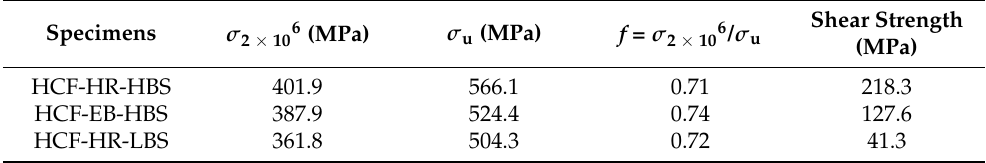
Figure 10. Comparison of the fatigue S-N curves between polished specimens and corresponding original plates. Table 6. Comparison of the fatigue